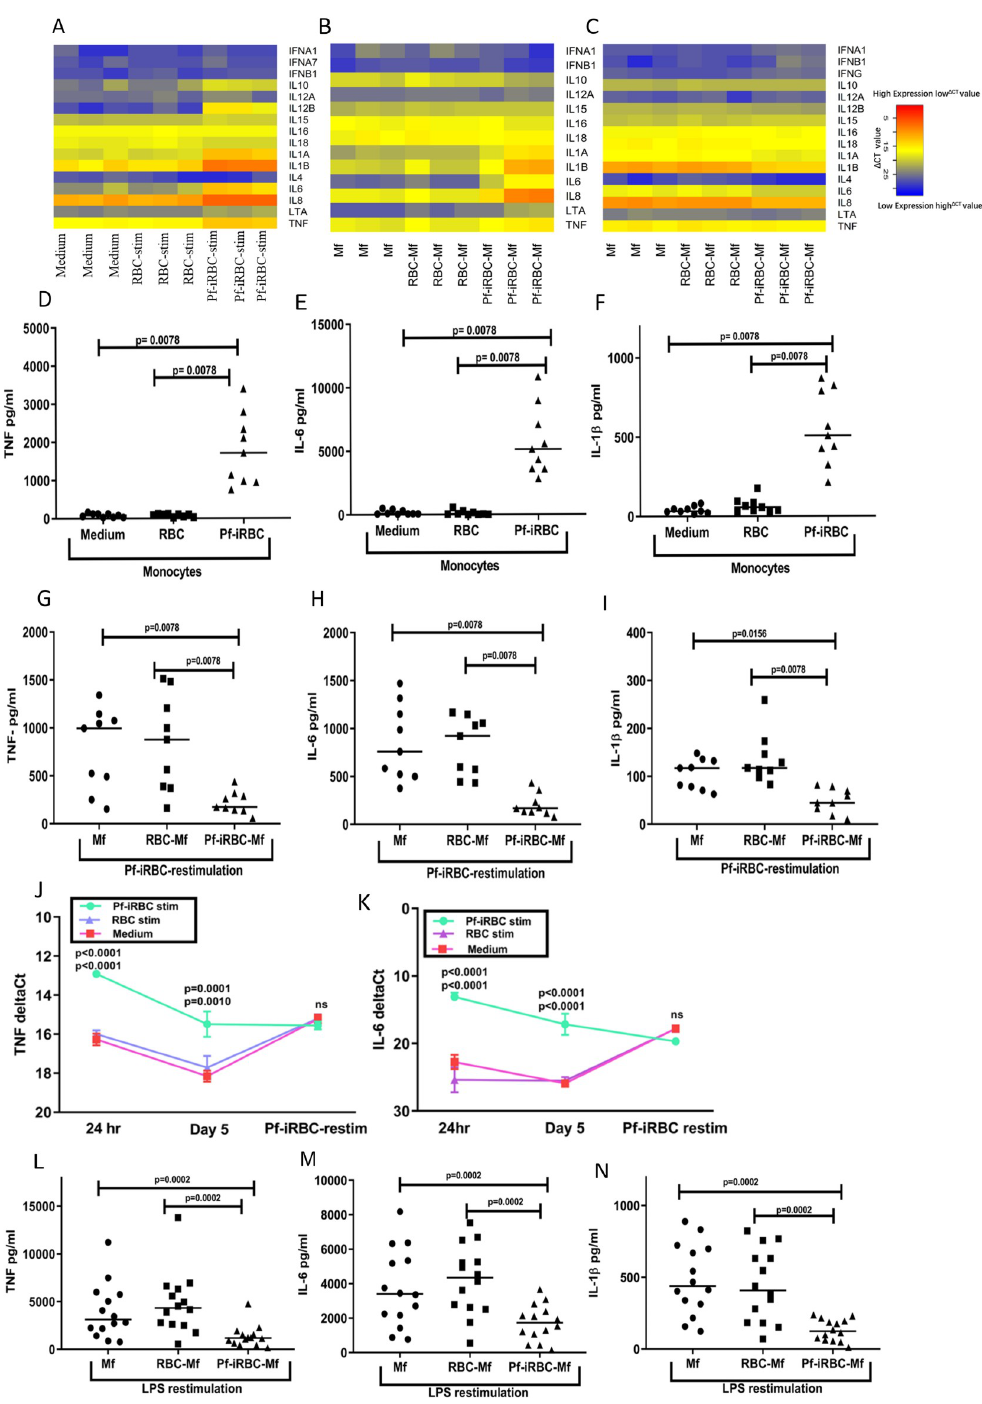
Fig 5. Pre-exposure of monocytes to P . falciparum dampens subsequent inflammatory responses to P . falciparum and LPS. Monocytes of U.S. adults were incubated with medium, RBC or Pf -iRBC. At 24 hours, cells were analyzed by ( A ) cytokine gene expression Taqman arrays (n = 3 subjects), and supernatants were analyzed by a bead-multiplexed assay (n = 9 subjects) to quantify ( D ) TNF, ( E ) IL-6 and ( F ) IL-1 β . In the same experiment, replicate monocytes were incubated with medium, RBC or Pf -iRBC, washed at 24 hours and incubated for 3 additional days in human serum to permit macrophage (Mf) differentiation. On day 5, the three populations of macrophages were analyzed by ( B ) cytokine gene expression arrays (n = 3 subjects). Finally, in the same experiment, replicate monocytes were incubated with medium, RBC or Pf -iRBC, washed at 24 hours, incubated for 3 additional days in human serum to permit Mf differentiation, and then